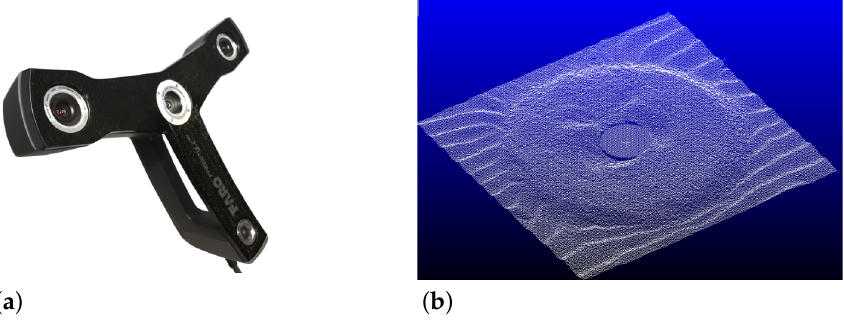
Figure 3. Faro R (cid:13) Freestyle 3D handheld laser scanner and post-processing: ( a ) Handheld laser scanner; ( b ) Post-processed gridded profile data obtained using the handheld laser